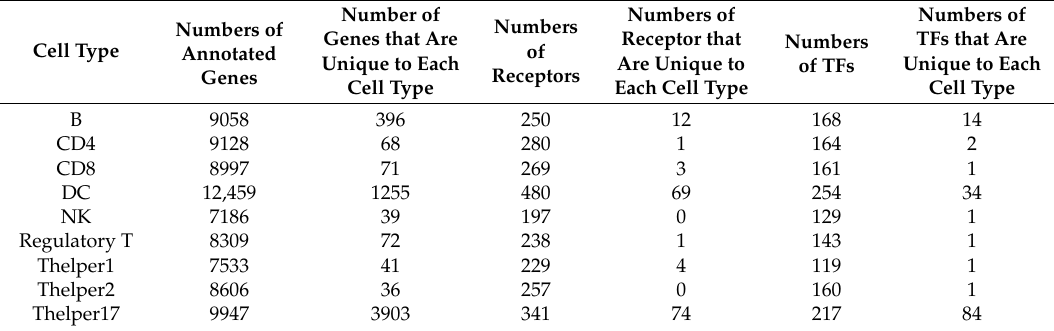
Table 1. The numbers of genes, uniquely regulated genes, cell receptors, and transcription factors in the gene regulatory networks of immune cells.